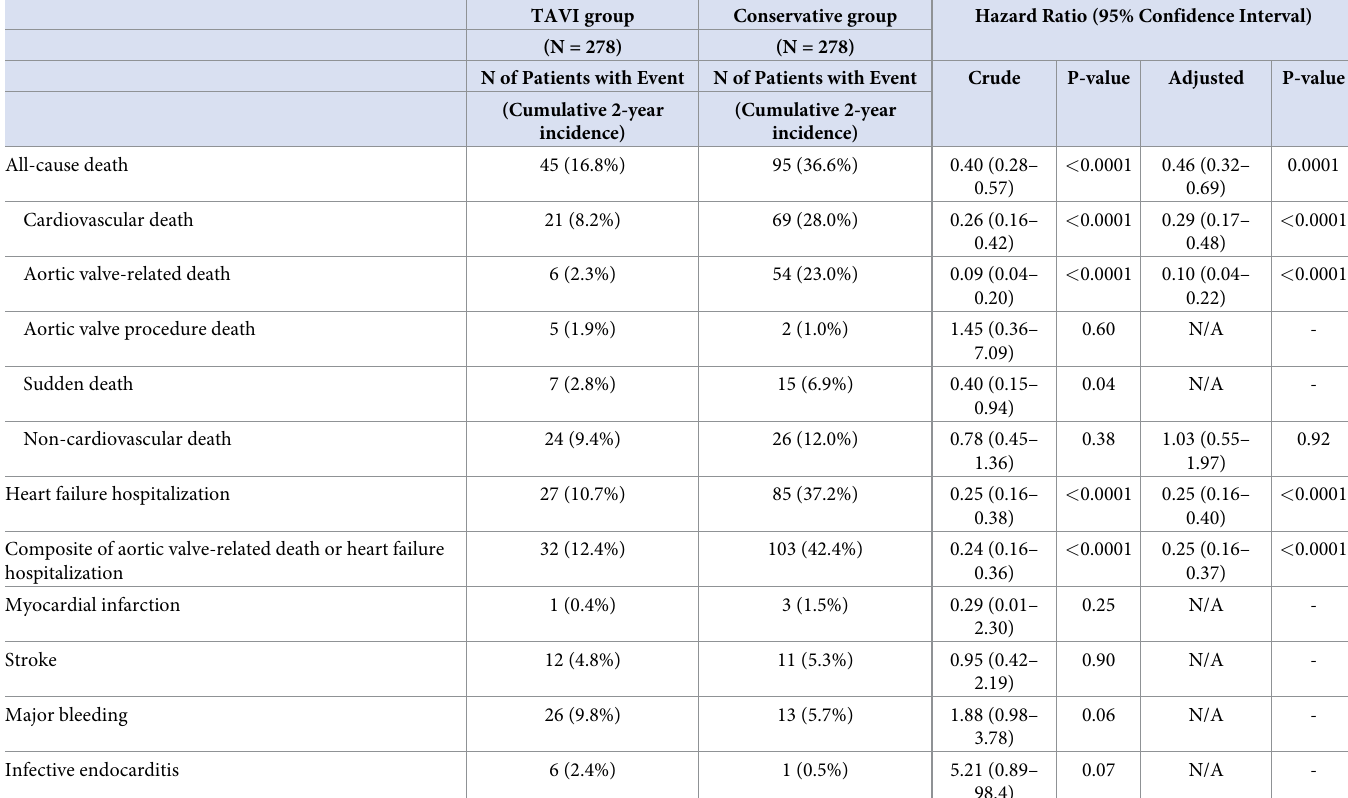
Table 2. Clinical outcomes: Propensity score-matched